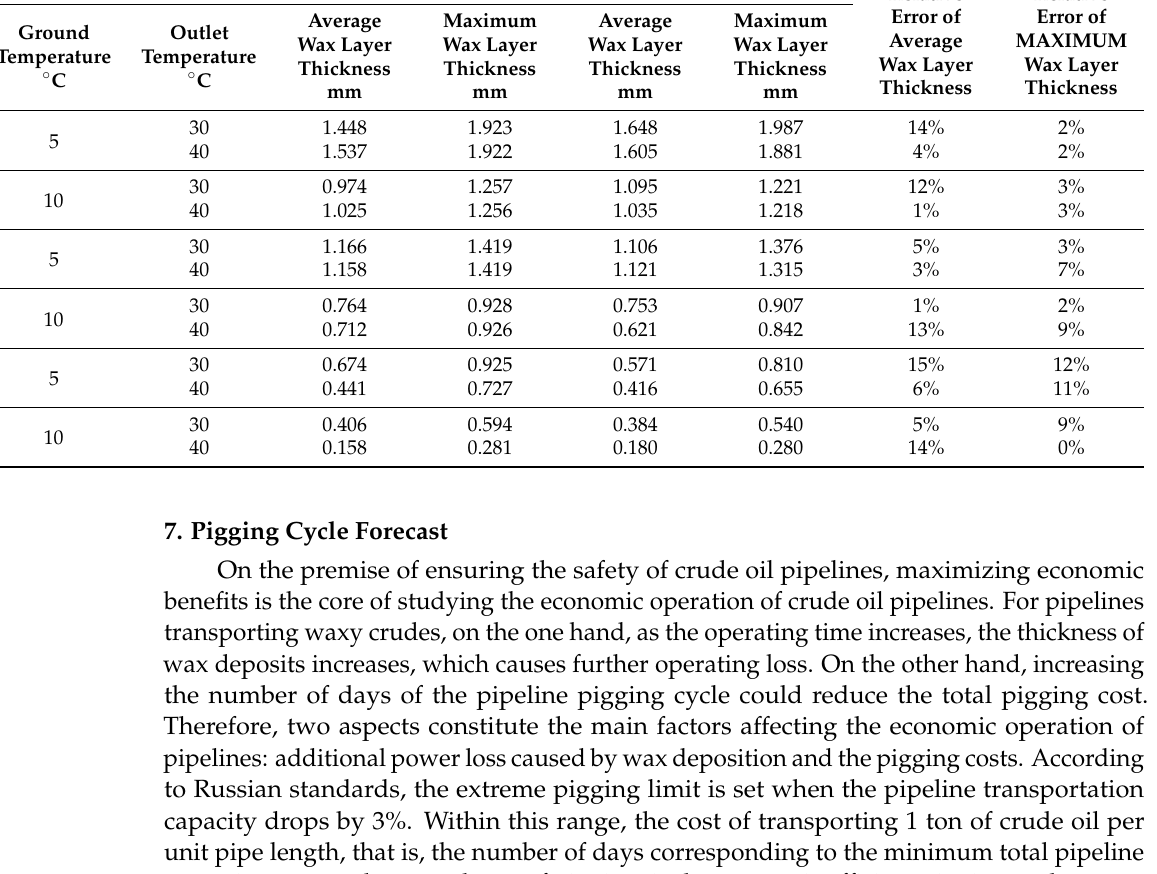
Table 4. The relative error between OLGA simulation results and Huang Qiyu model prediction results. Simulation